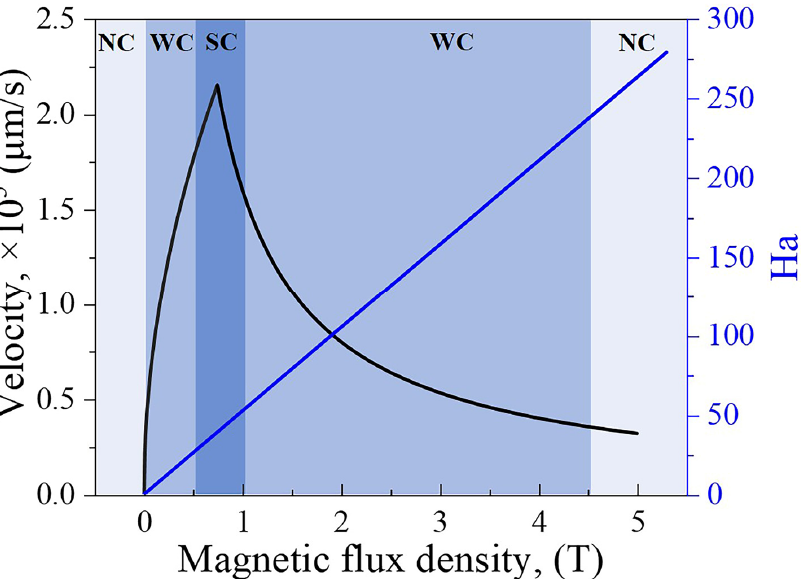
Figure 6. The curves of melt velocity caused by the TEMC and Ha numbers under various MFDs. NC, WC, and SC represent three different intensities of melt convection, respectively.